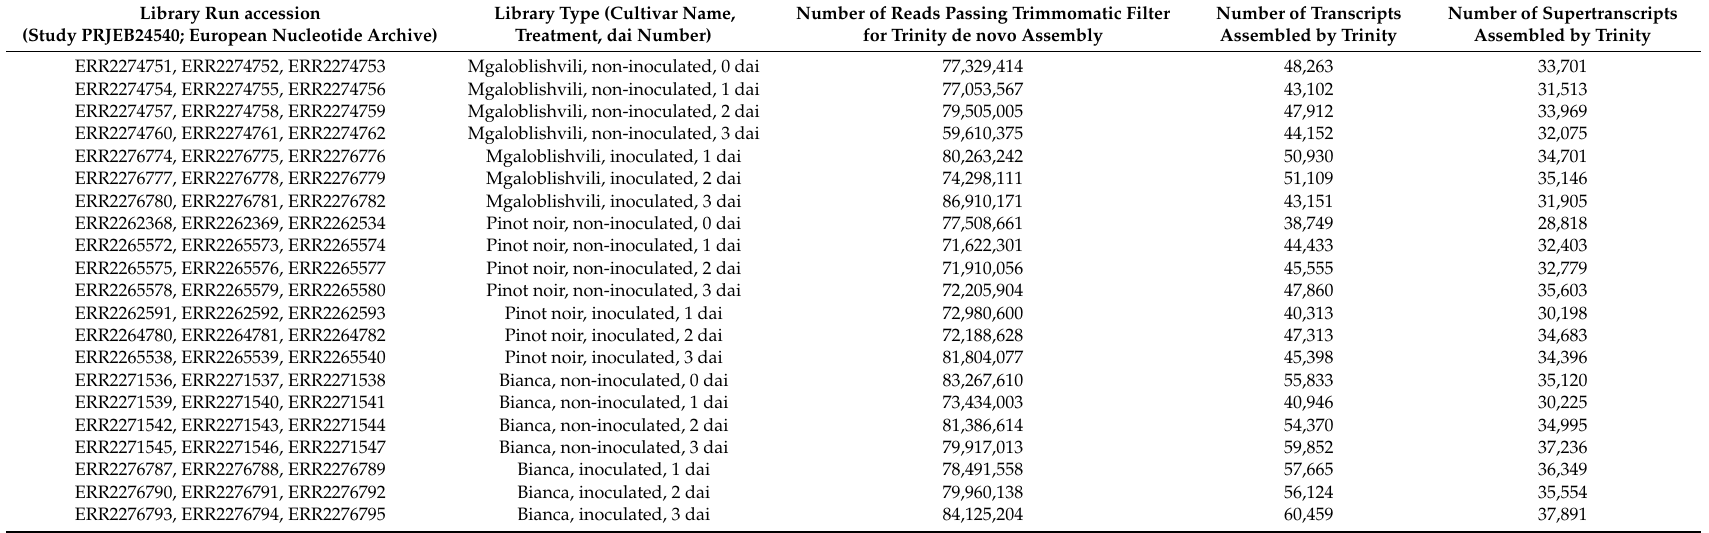
Table 2. Number of de novo transcripts assembled by Trinity for each condition and genotype analyzed. The run accession numbers associated with the respective sample type are reported. Supertranscripts indicate the number of transcripts after collapsing unique and common sequence regions among splicing